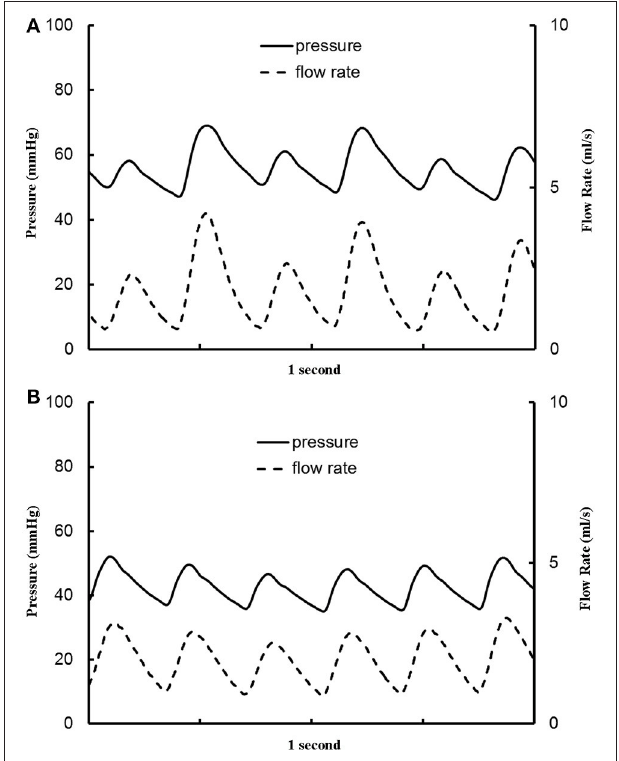
FIGURE 4 | Pressure and flow waves in femoral artery (A) after the heart rate was paced to 170 bpm and (B) after the heart rate was paced to 170 bpm with I.V. injection of papaverine (100mg per